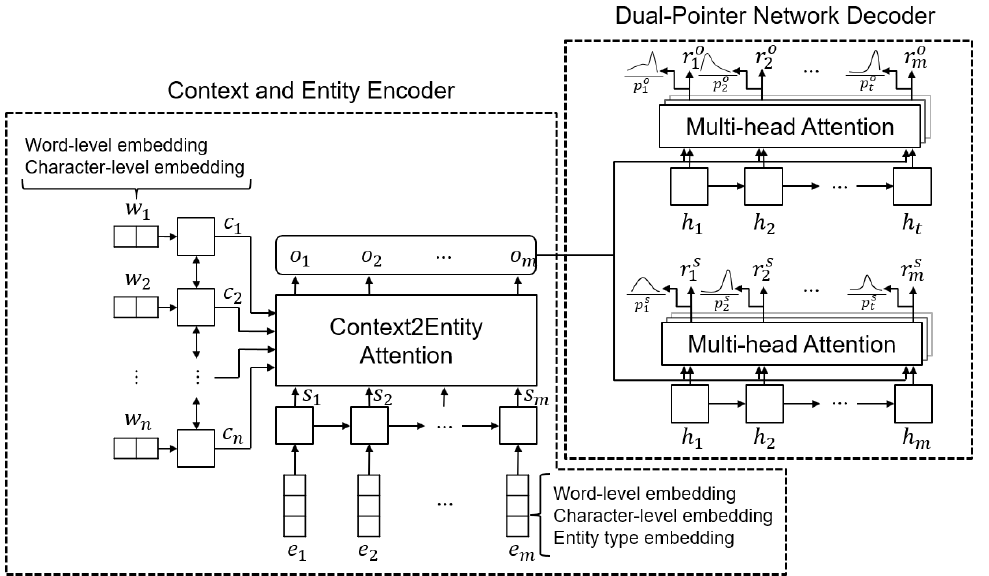
Figure 2. The overall architecture of dual pointer networks for relation extraction.